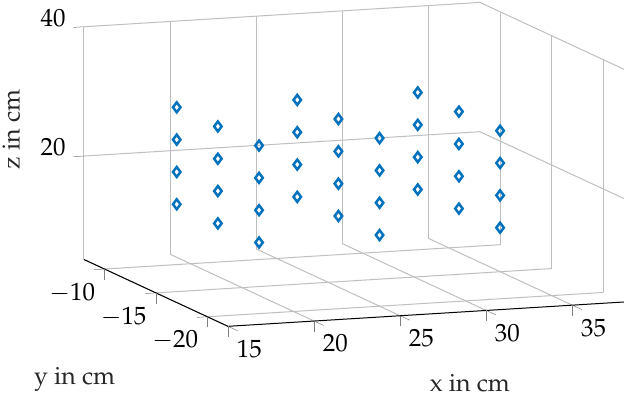
Figure 17. 36 chosen points for the demo calibration